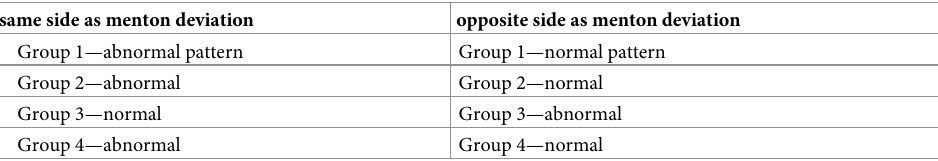
Table 1. Criteria for normal vs. abnormal condyle variation in asymmetry condyle height or area